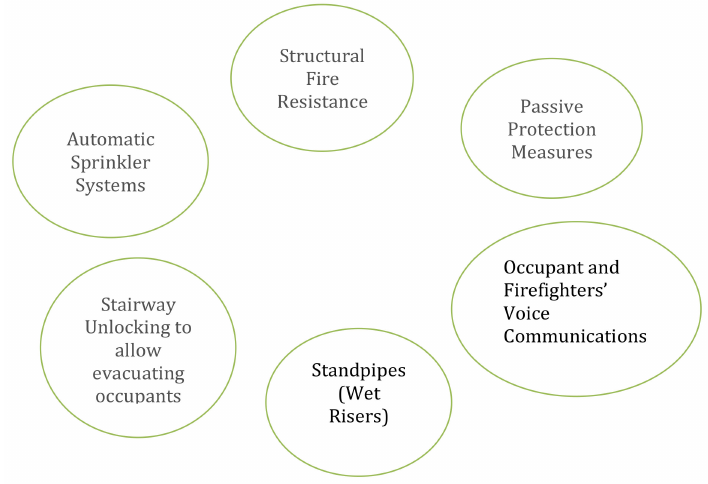
Figure 1. Six fundamental pillars of fire safety in